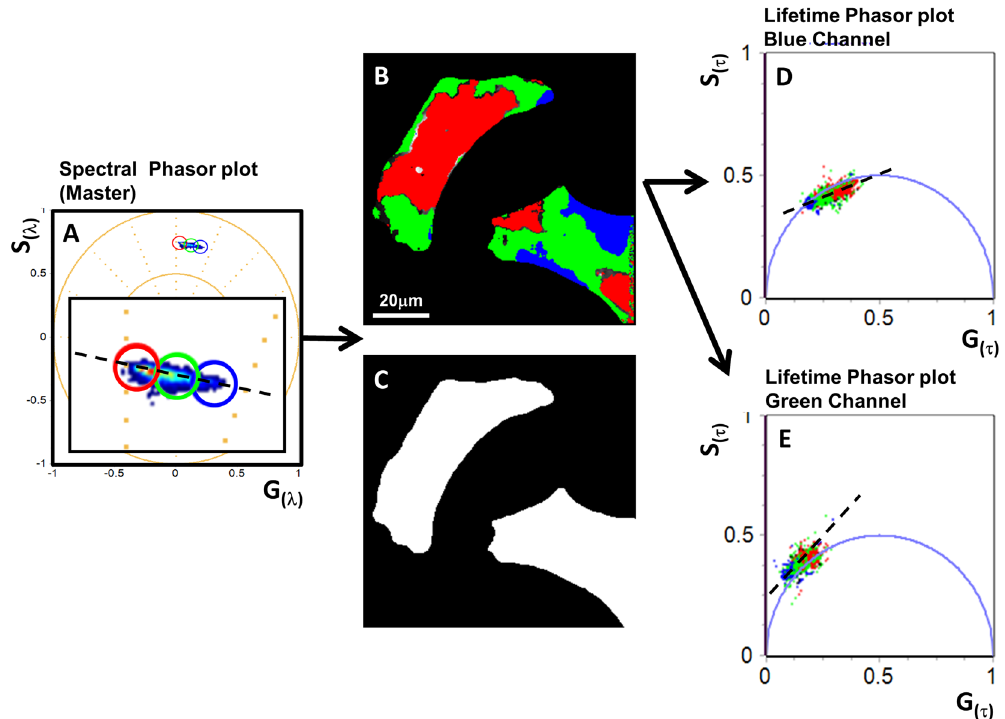
Figure 5. Multi-D phasor analysis of the LAURDAN fluorescence in NIH-3T3 internal membranes. ( A ) Spectral phasor plots (master) and cursor selection (red, green and blue) of different ROI in the phasor plot. ( B ) Color-coded images generated by the cursor selection according to the master (spectral) phasor plot. ( C ) Mask used by the analysis in ( B,D and E ) Lifetime phasor plots (blue and green channels, see Material and Methods for the channel transmission